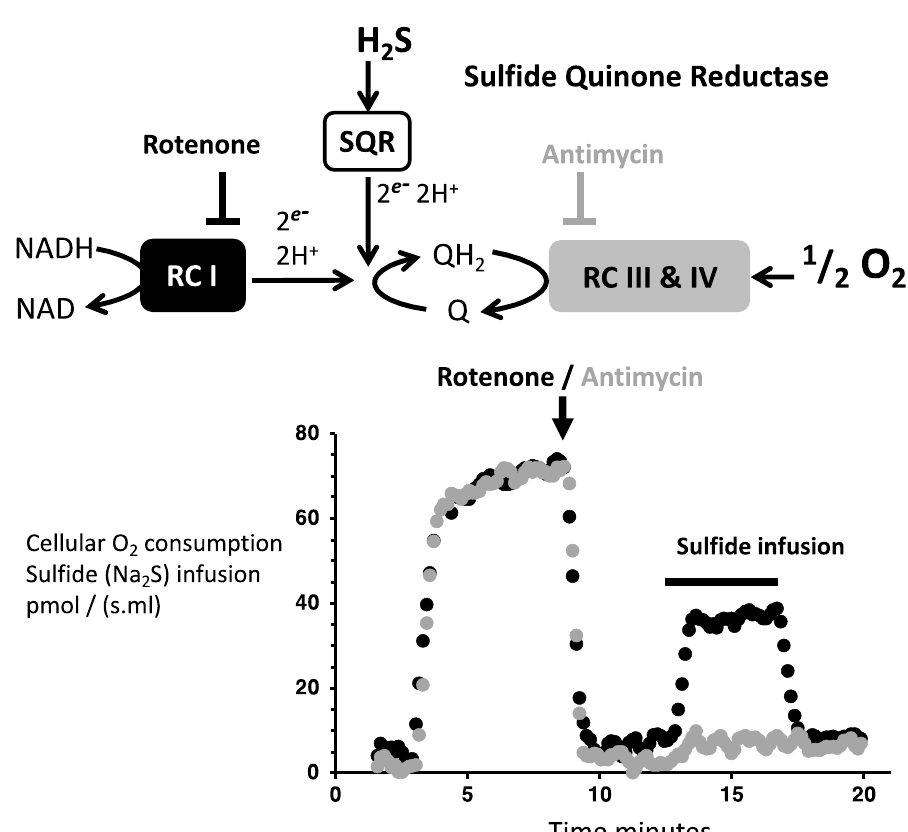
Figure 3. Mitochondrial Sulfide Quinone Reductase activity. Top : Branching of SQR on the mitochondrial respiratory chain the mitochondrial complexes I (RC I) and III and IV (RC III & IV) are shown as boxes. Bottom : Experiment with inhibitors to demonstrate sulfide quinone reductase activity in the mitochondrial respiratory chain. The X-axis time in minutes, the Y -axis rates of cellular oxygen consumption (CHO cells ≈ 10 6 cells/mL) or sulfide infusion, and the oxygen consumption rate were followed simultaneously in two chambers. Experiments started by closure of the chambers (before 5 min), and after recording endogenous cellular respiration (from 5 to 8 min approximately), the inhibitors of respiratory complex I (rotenone) or III (antimycin) were added (black/gray trace respectively). Then, the same sulfide infusion was settled in the two chambers for the period of time indicated by the black horizontal bar. Oxygen consumption increases synchronously with infusion in the presence of rotenone, while it remains low in the presence of antimycin. Remember that the Y ordinate (45) for the horizontal black bar refers to the sulfide flux, which could be directly compared to the oxygen consumption rate it caused (here roughly 30); hence, in this experiment O 2 /H 2 S = 0.67. Note that colored versions of Figures 3–10 are provided in the Supplementary